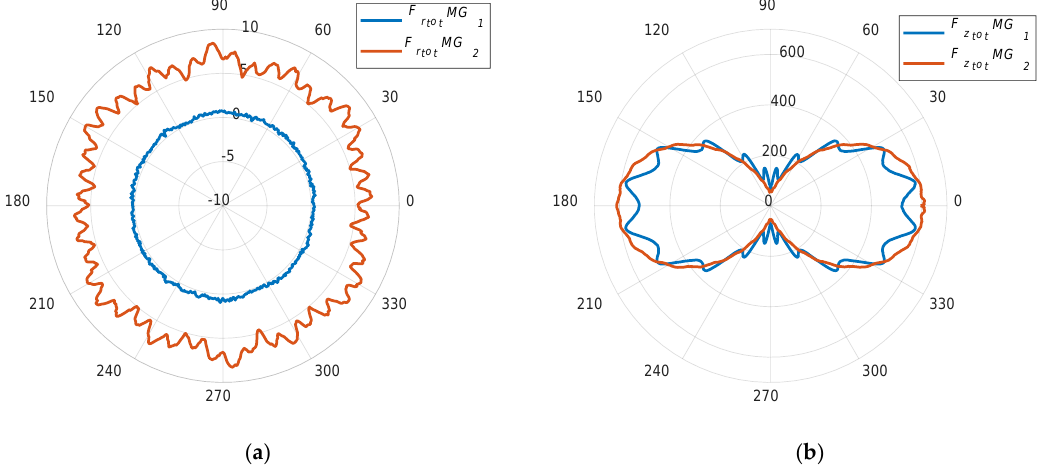
Figure 6. Comparison of RUMF ( a ) and AUMF ( b ) for the two gear variants vs. high-speed rotor angle position, by fixed low-speed rotor and modulator.